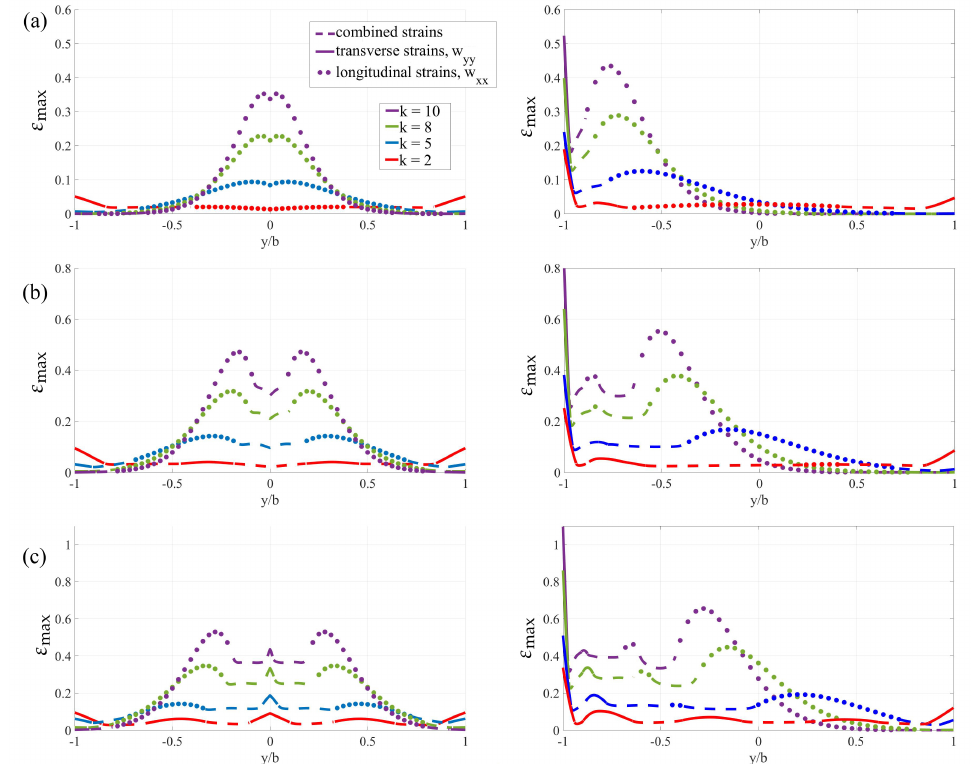
Figure 9. The scaled maximum strains ε max ( y ) in the hydroelastic wave along the phase for the first three modes for different values of k and with h 0 = 0.0015 m. Here, ( a )—first mode, ( b )—second and ( c )—third one. All notations are the same as in Figure